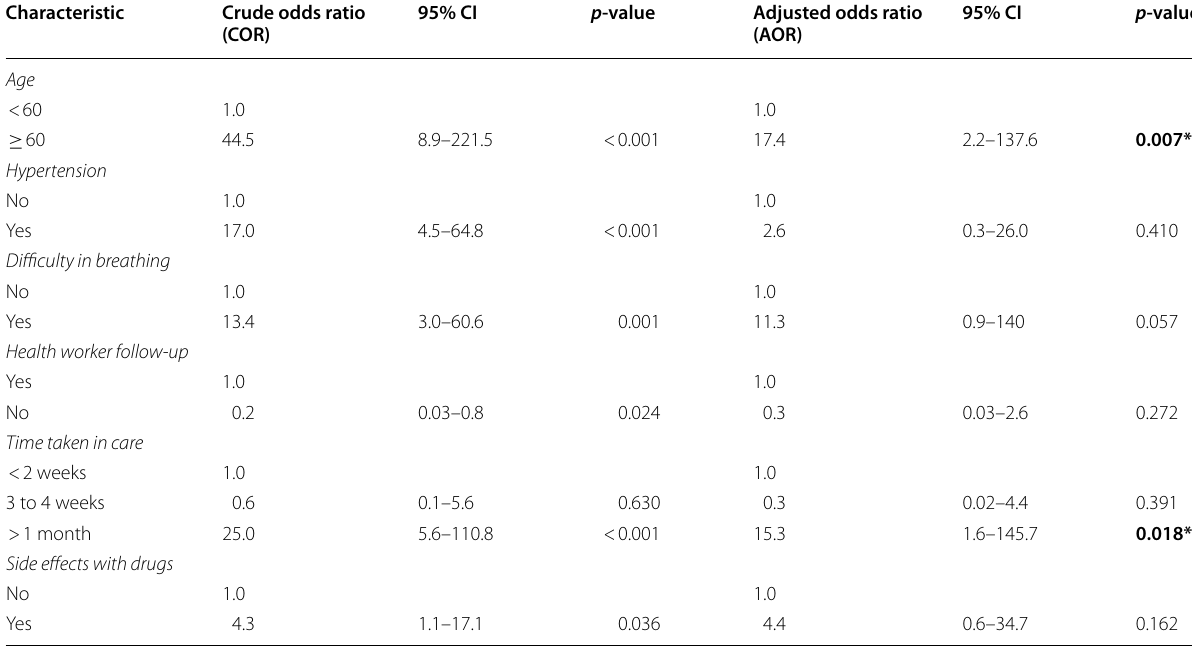
Table 5 Determinants of poor treatment outcomes among COVID‑19 patients managed under home‑based care in Kapelebyong district in eastern